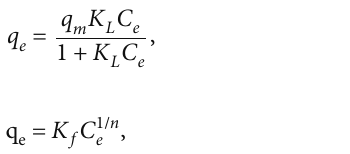
Figure 1: RM treated with 4N hydrochloric acid.